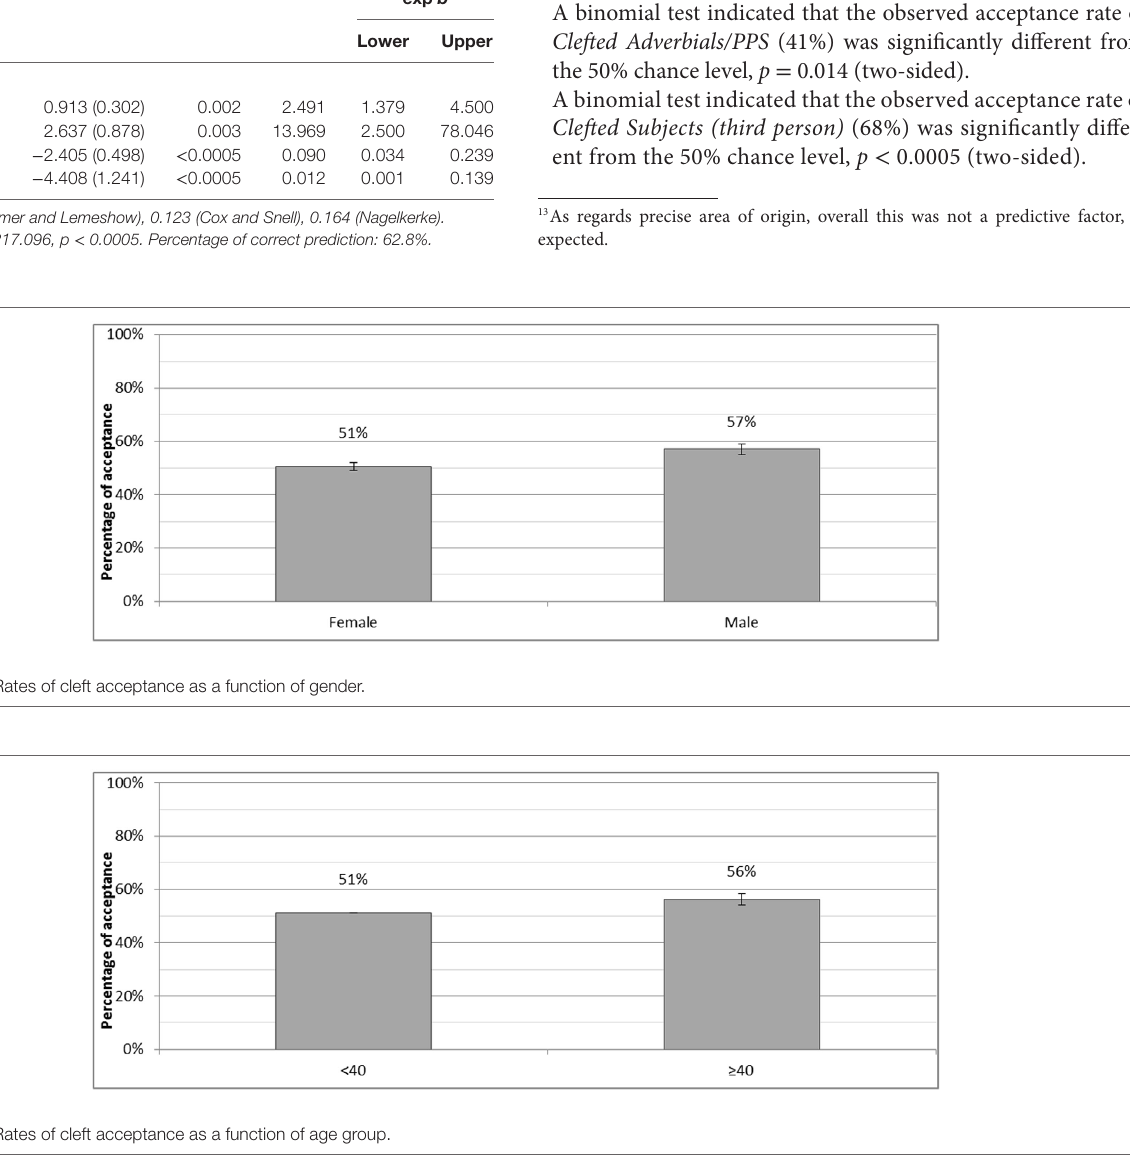
FigUre 2 | Rates of cleft acceptance as a function of age